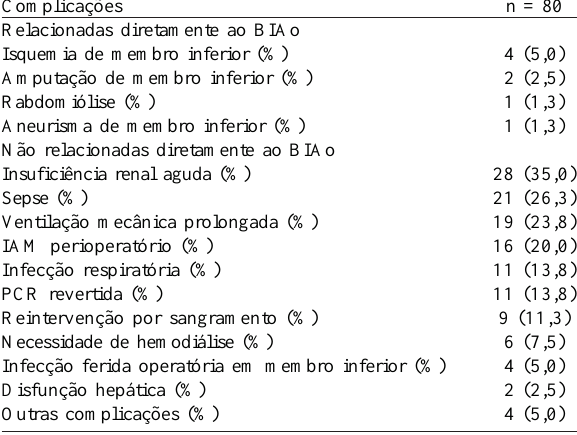
Fig. 1 - Curva de sobrevida de Kaplan-Meier